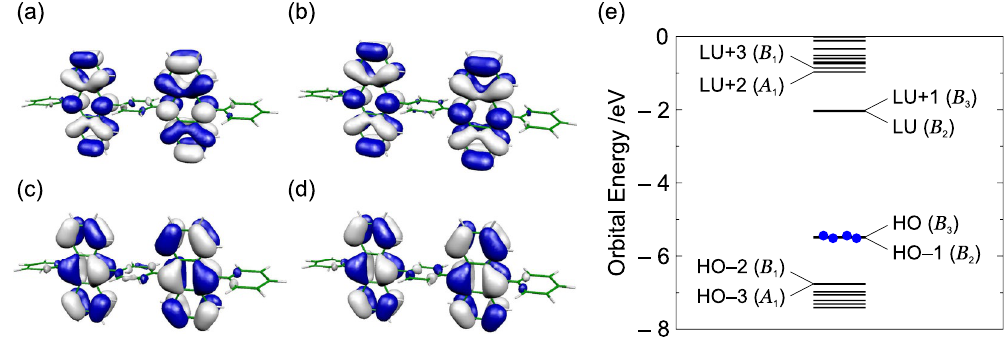
Figure 2. Frontier orbitals of BD1: ( a ) B 2 LUMO, ( b ) B 3 NLUMO, ( c ) B 3 HOMO, and ( d ) B 2 NHOMO. The isosurface value is 2.0 × 10 − 2 a.u. ( e ) Frontier orbital levels of BD1. It should be noted that the HOMO and next HOMO as well as the LUMO and next LUMO are pseudo-degenerate, respectively.